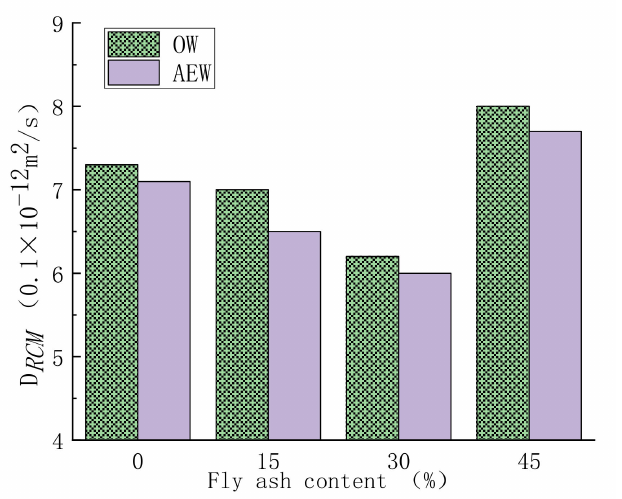
Figure 18. Chloride ion transport coefficient of concrete with OW and AEW with a pH value of 11.5 under different FA